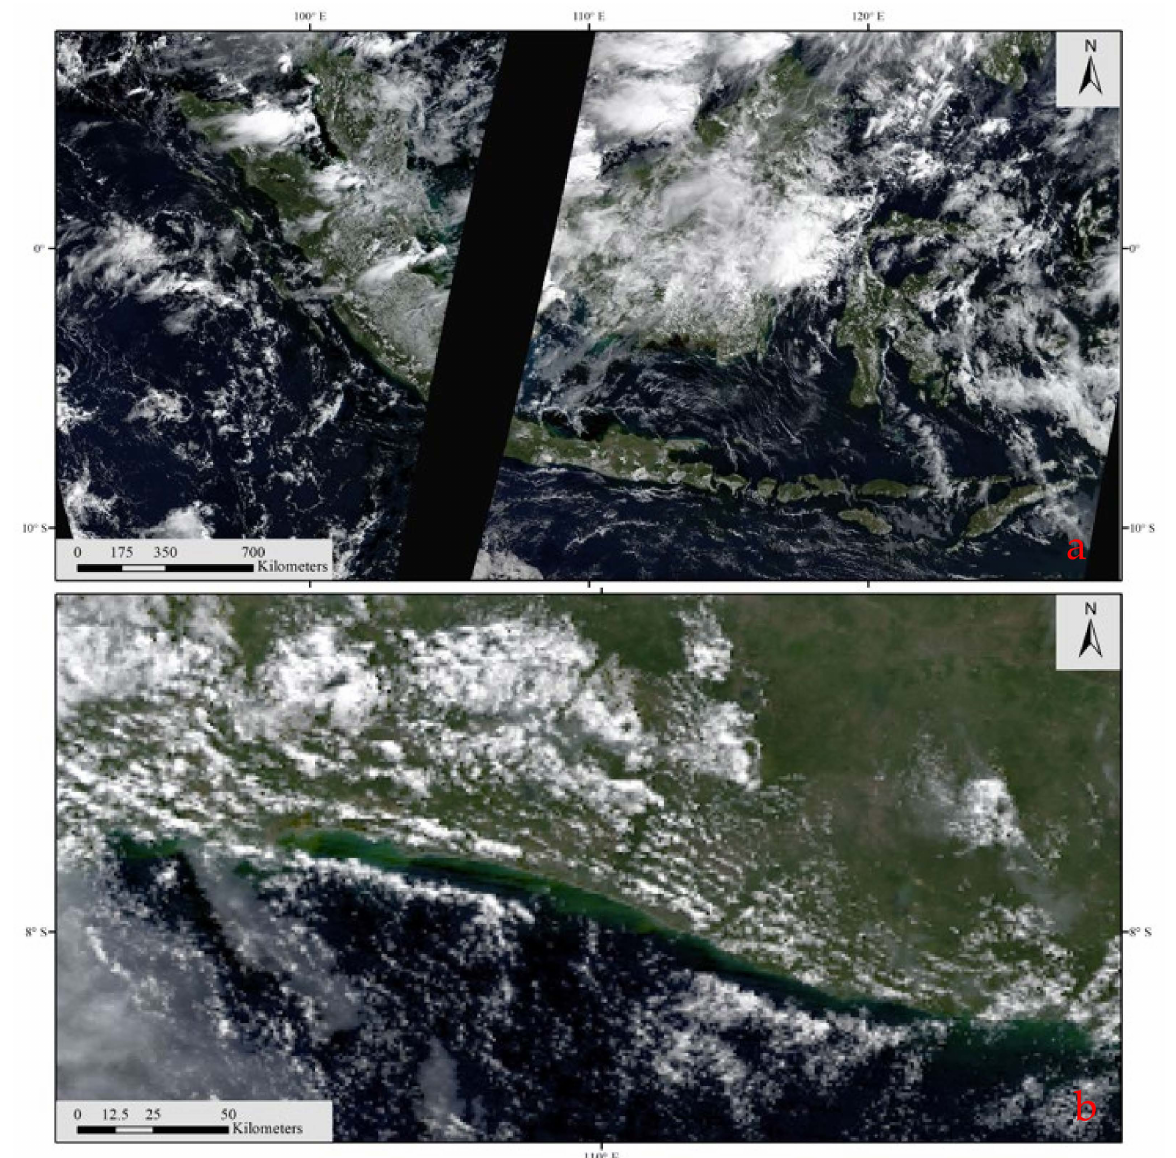
Figure 22. The true-color images (band 1, 4, 3) of Sumatra on 8 June 2011 ( a ) and 1 June 2010 ( b